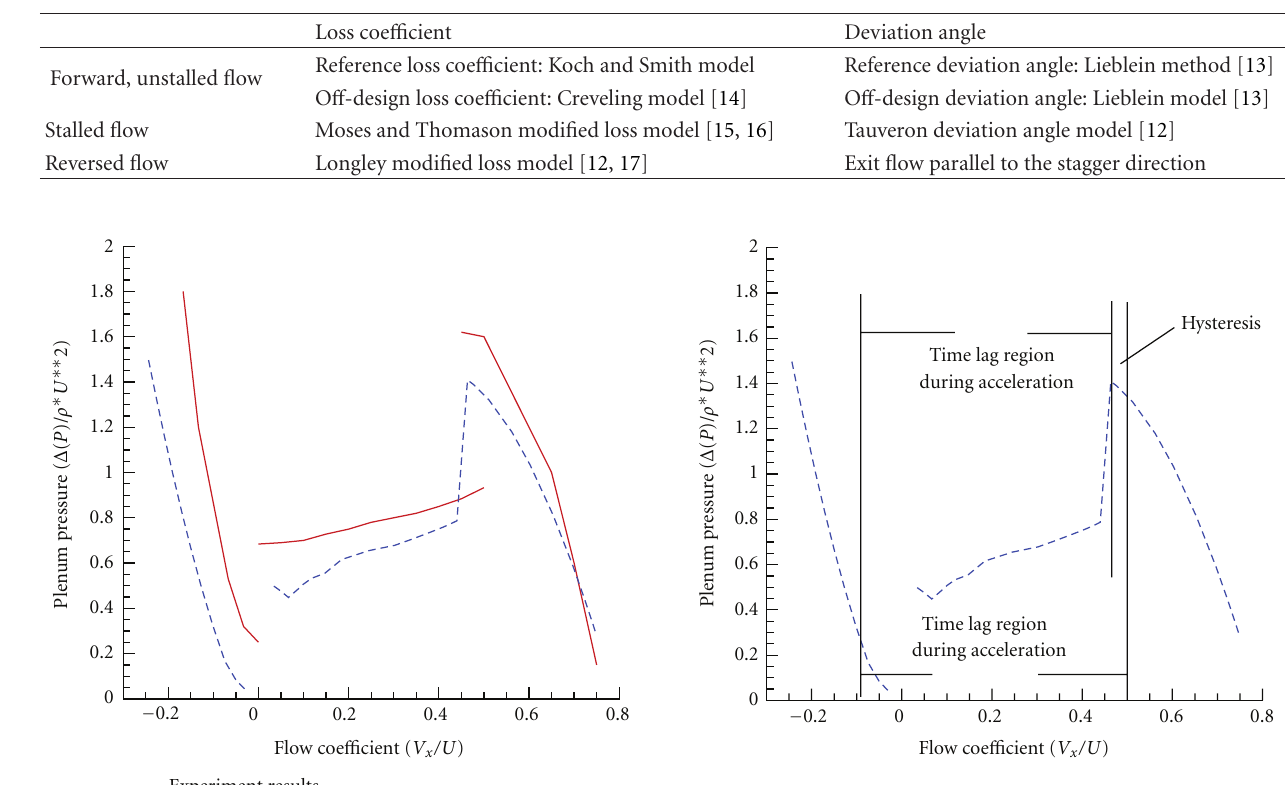
Table 1: Selected empirical correlations.